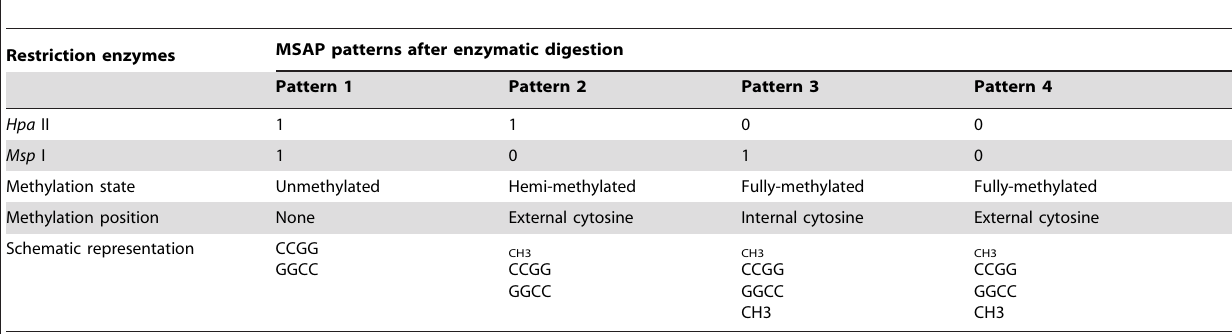
Table 4. MSAP patterns corresponding to different methylation states of the symmetric sequence CCGG, as revealed by the specificity of the restriction enzymes Hpa II and Msp